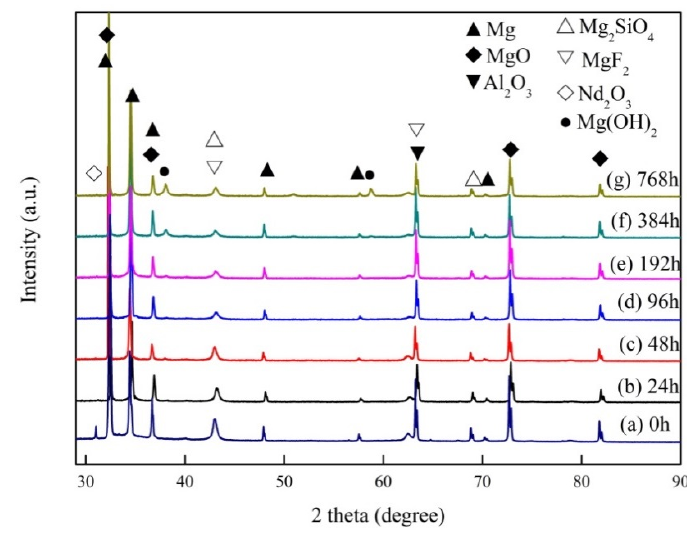
Figure 9. XRD patterns of (350–6) after immersion at different times.